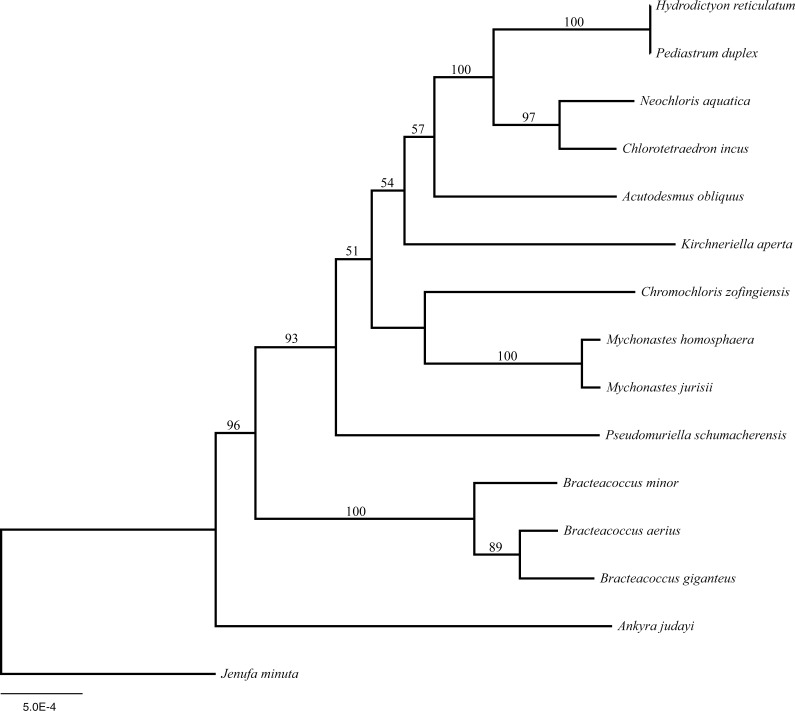
Maximum likelihood tree using plastome gene order within Sphaeropleales.ML bootstrap support values >50, based on 1,000 replicates, are indicated above each node.